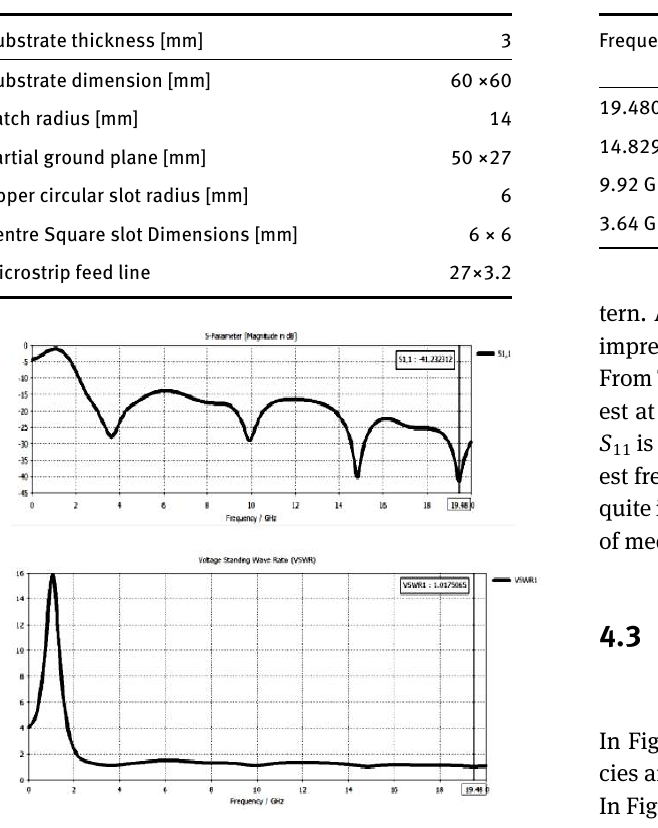
and also total efficiency is also measured from simulated results of desired antenna.